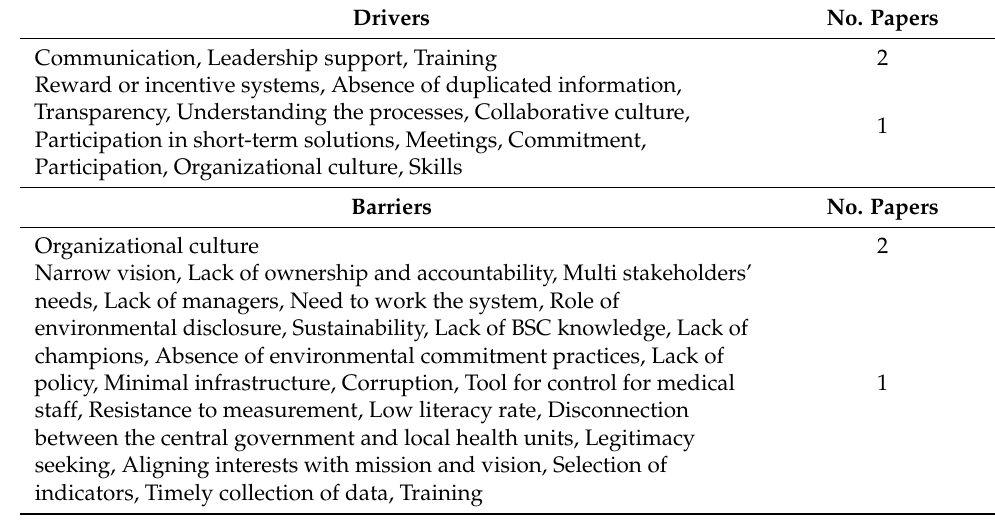
Table 8. Drivers and barriers identified from the selected papers.